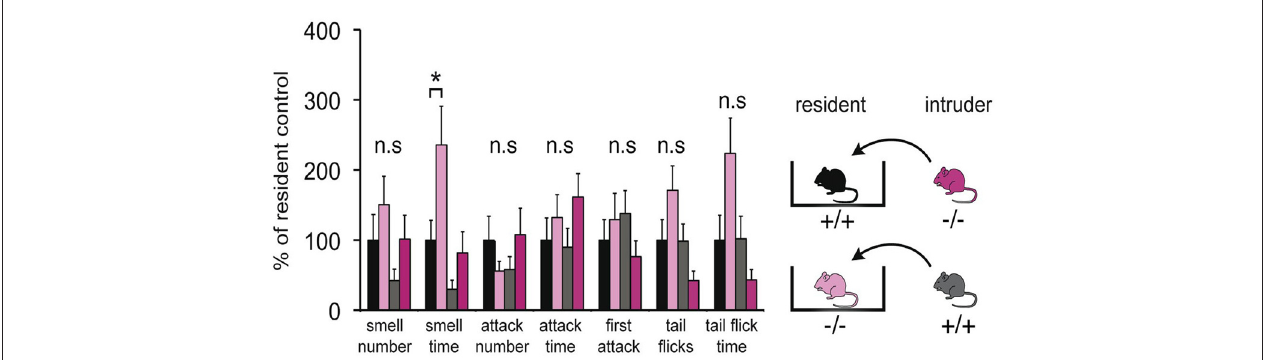
FIGURE 6 | Behavioral comparison of Panx1 + / + and Panx1 − / − mice . This modified intruder assay with N = 14 (Panx1 + / + ) and N = 15 (Panx1 − / − ) mice demonstrates that there are no significant differences in three behavioral categories, including aggressive behaviors mediated by the VNO (tail flicks, attacks indicated by biting, chasing, cornering and tumbling), between the two different mouse lines. A significant increase in smell time was found for Panx1 KO resident mice. The cartoon outlines the strategy used. Error bars indicate SEM. ∗ p <